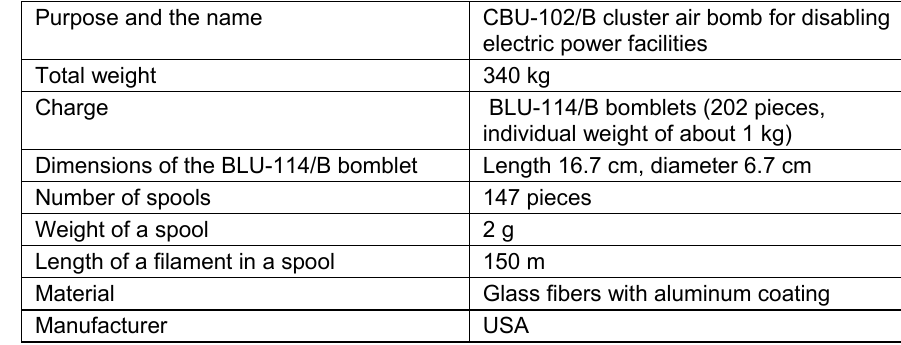
Table 1 – Technical characteristics of the CBU-102/B cluster air bomb